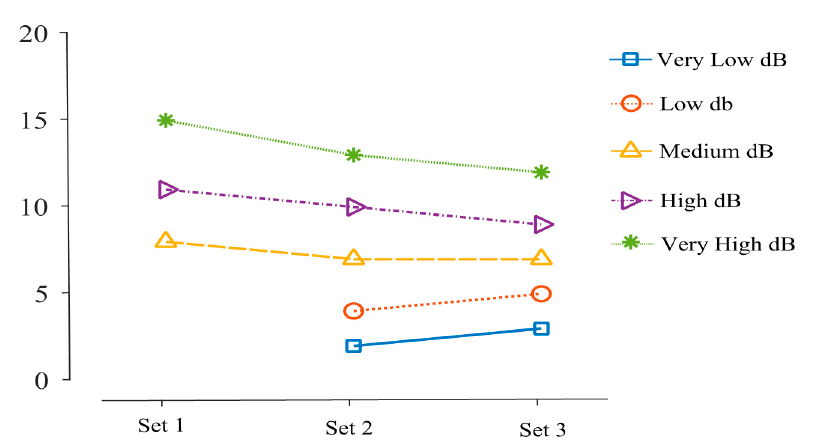
Figure 7. Volume level for selected sets.